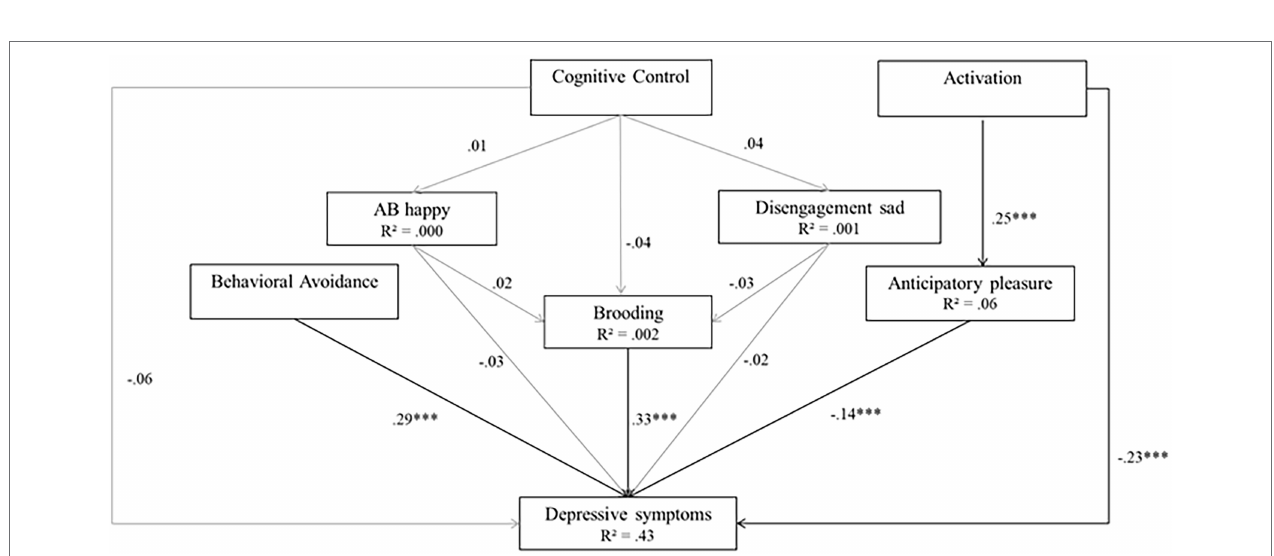
FIGURE 6 | Model 4 (comprehensive model). Initial structural equation model. Rectangles represent observed measured variables. Values are path-standardized coefficients. R 2 represents the proportion of the variance for a dependent variable that is explained by an independent variable or variables in a regression model. *** indicates a significant path coefficient at p < 0.01. * indicates a significant path-coefficient at p < 0.05. (black: p < 0.05; gray: p >